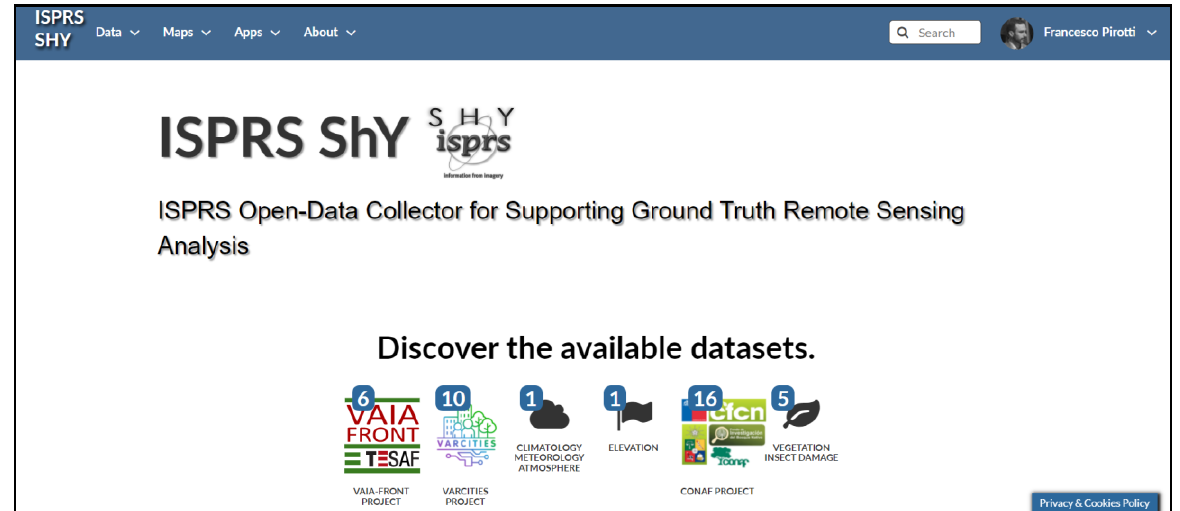
Figure 1. Front page of ISPRS-Shy data portal, with projects and datasets; accessible at https://isprs-shy.cirgeo.unipd.it